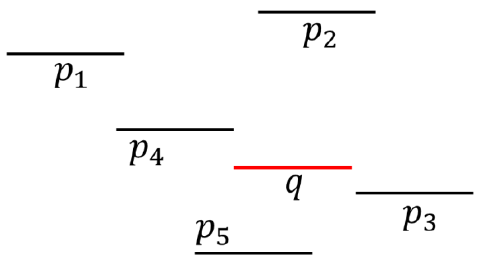
, , p p p are non-zero NN of uncertain query Figure 1.   3 4 5